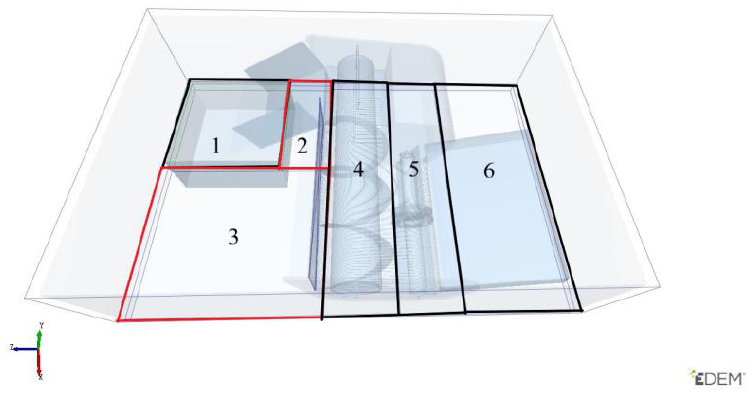
Figure 7. Vibration process region division.